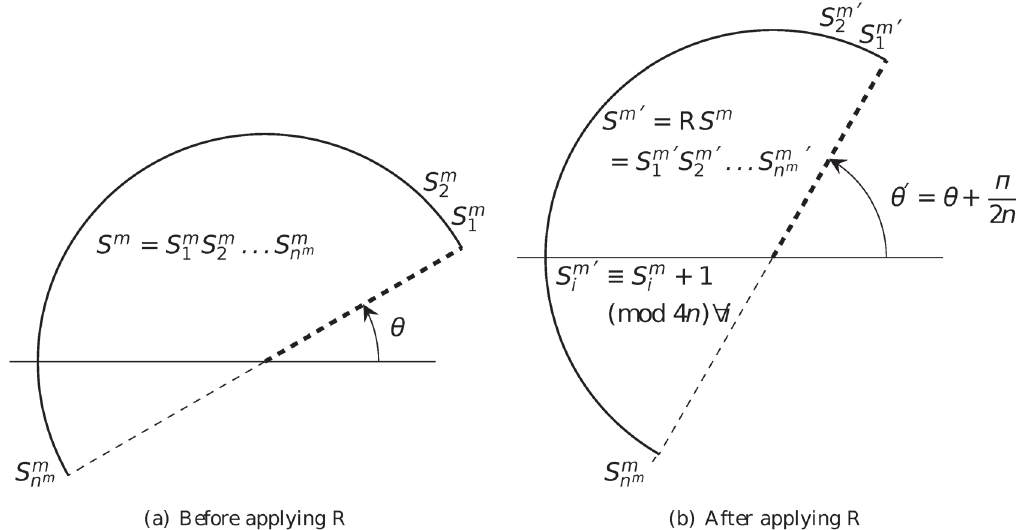
Fig 7. Action of the rotation operator R .